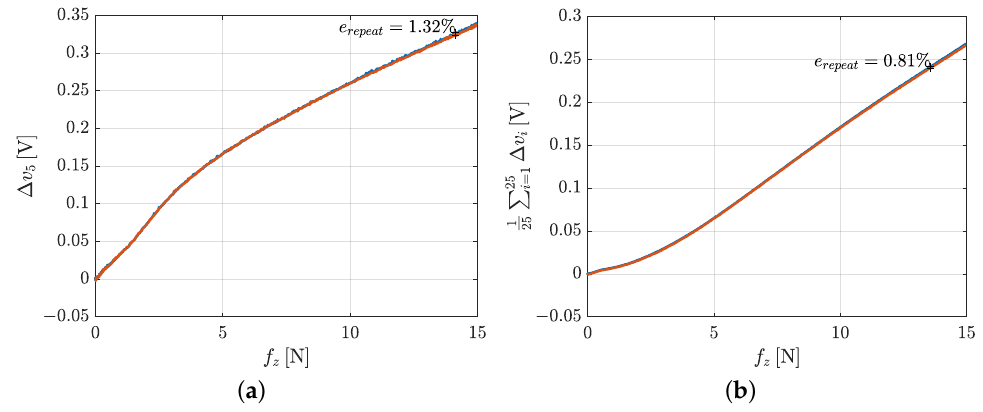
Figure 17. Repeatability graph for the whole pad characterization: a single voltage ( a ) and mean of voltages ( b